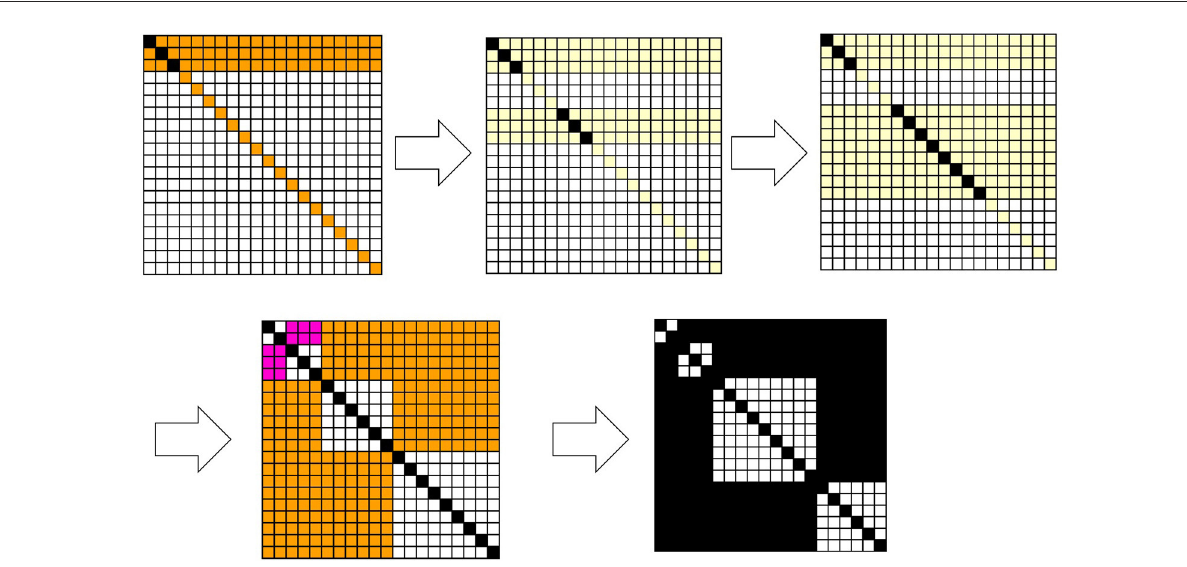
FIGURE3 Snapshots of the joint probabilities of data and hypotheses and their corresponding relation R . The articulation of the data and hypotheses with respect to the diagonal elements is determined by Equation 22. The joint probabilities are colored from low to high in the order of white, pale yellow, orange, pink, and black. The last diagram in the sequence ordered by the arrows represents a binary relation. A black cell at ( h , d ) represents ( h , d ) ∈ R , and a white cell represents ( h , d ) / ∈ R